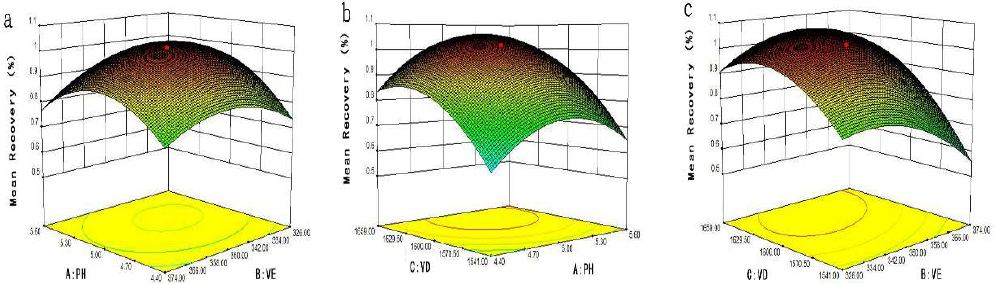
Figure 2. Response using the central composite design obtained by plotting: ( A ) pH; ( B ) VE: volume of extraction solvents; ( C ) VD: Volume of dispersive solvent, and (f) NaCl percentage vs. volume of dispersive solvent. Table 3. Analysis of variance (ANOVA) for response surface quadratic model (12 analytes).